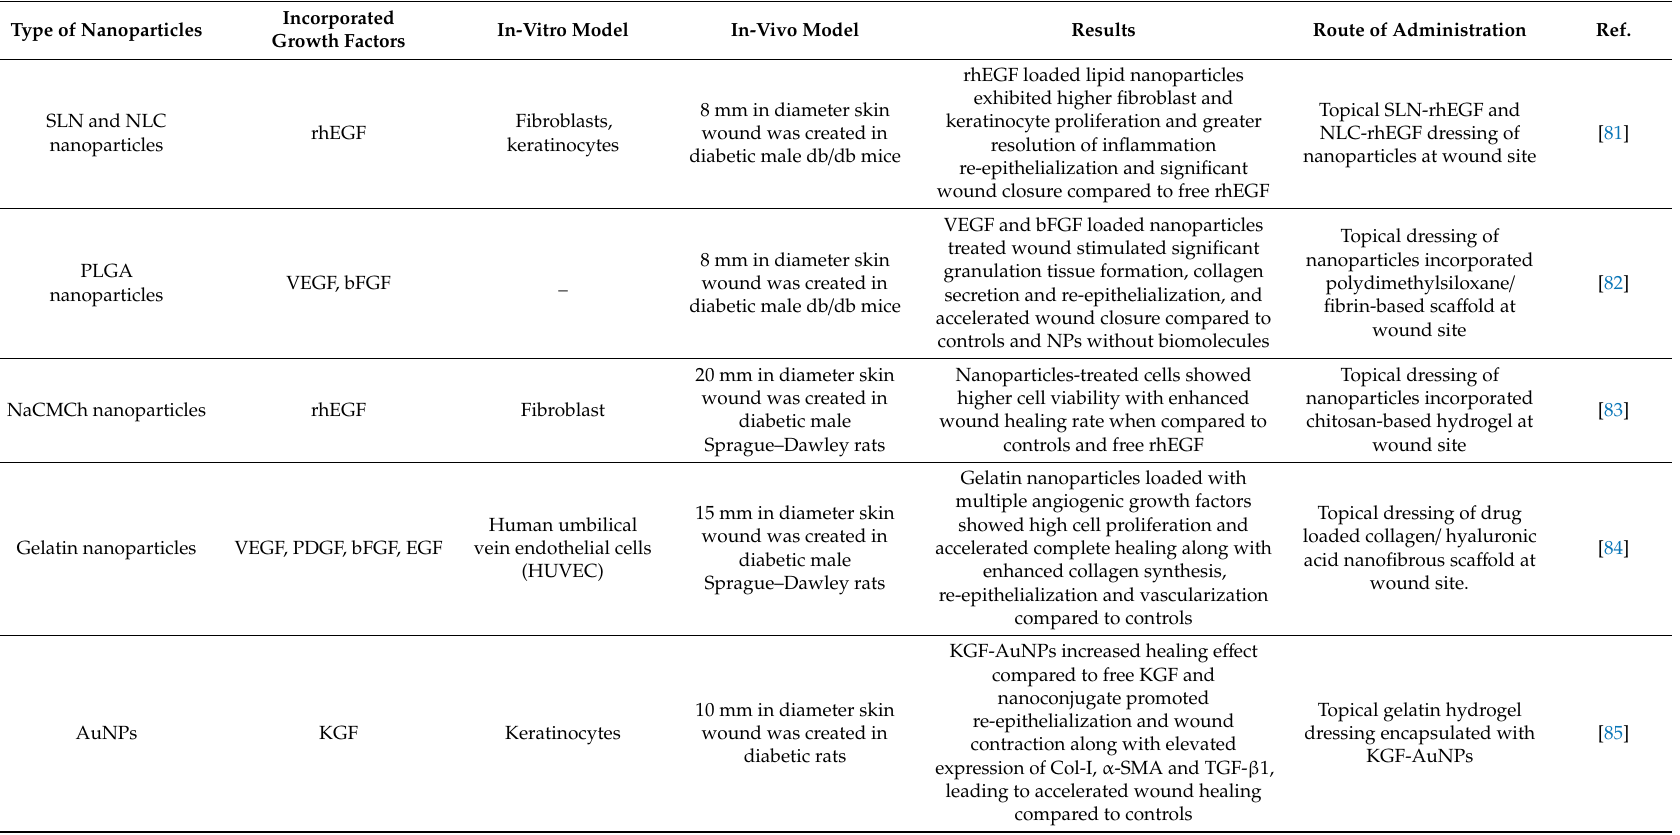
Table 1. Nanoparticles-based therapeutic incorporated with growth factors for diabetic wound